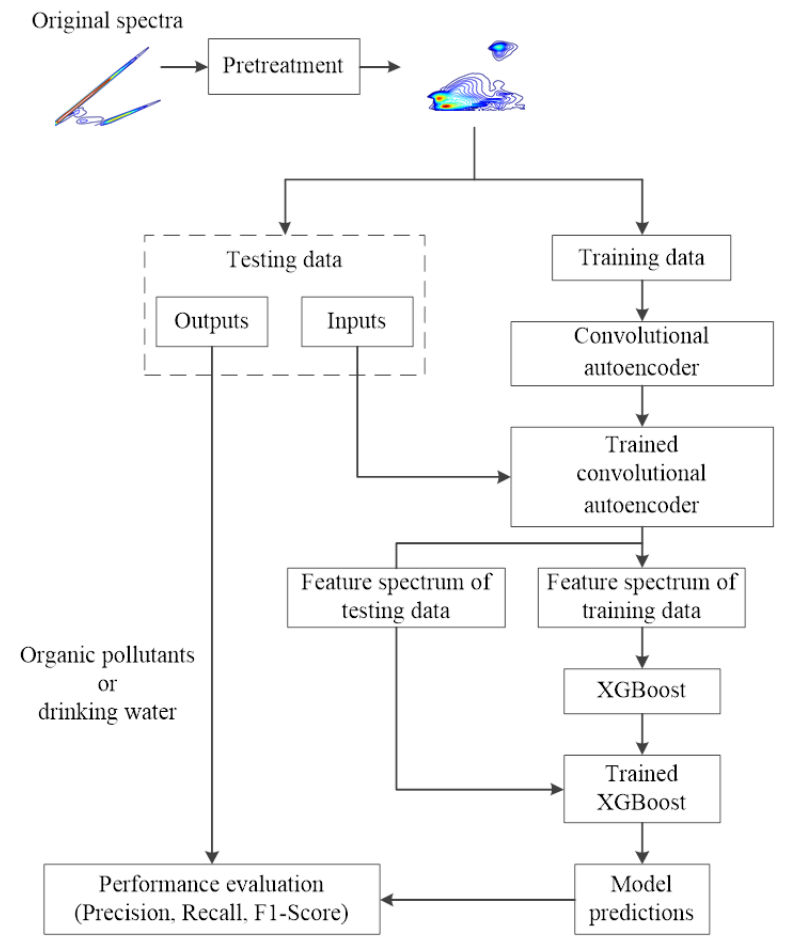
Figure 1. Flow chart of the proposed method to identify and measure organic pollutants in water